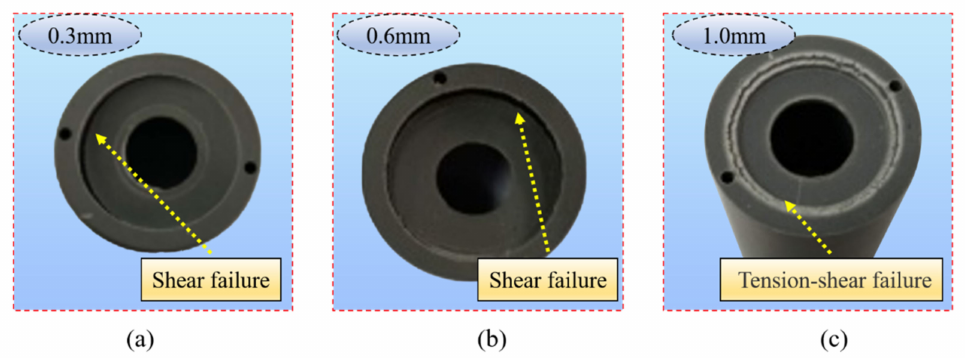
Figure 13. Failure patterns of top plates of different thicknesses. ( a ) shear failure; ( b ) shear failure; ( c ) tensile shear